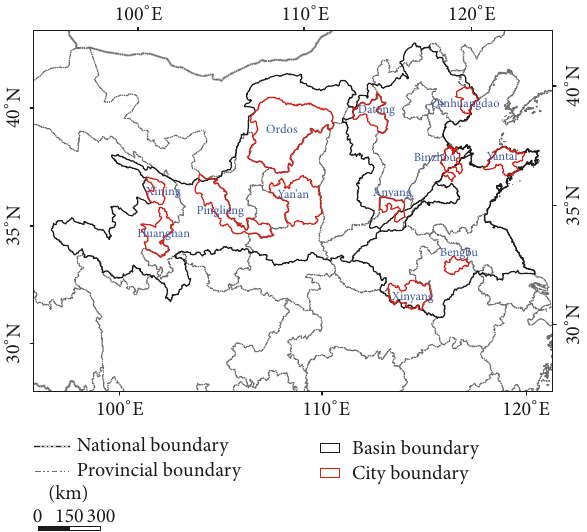
Figure 26: Spatial distribution of the selected twelve cities.